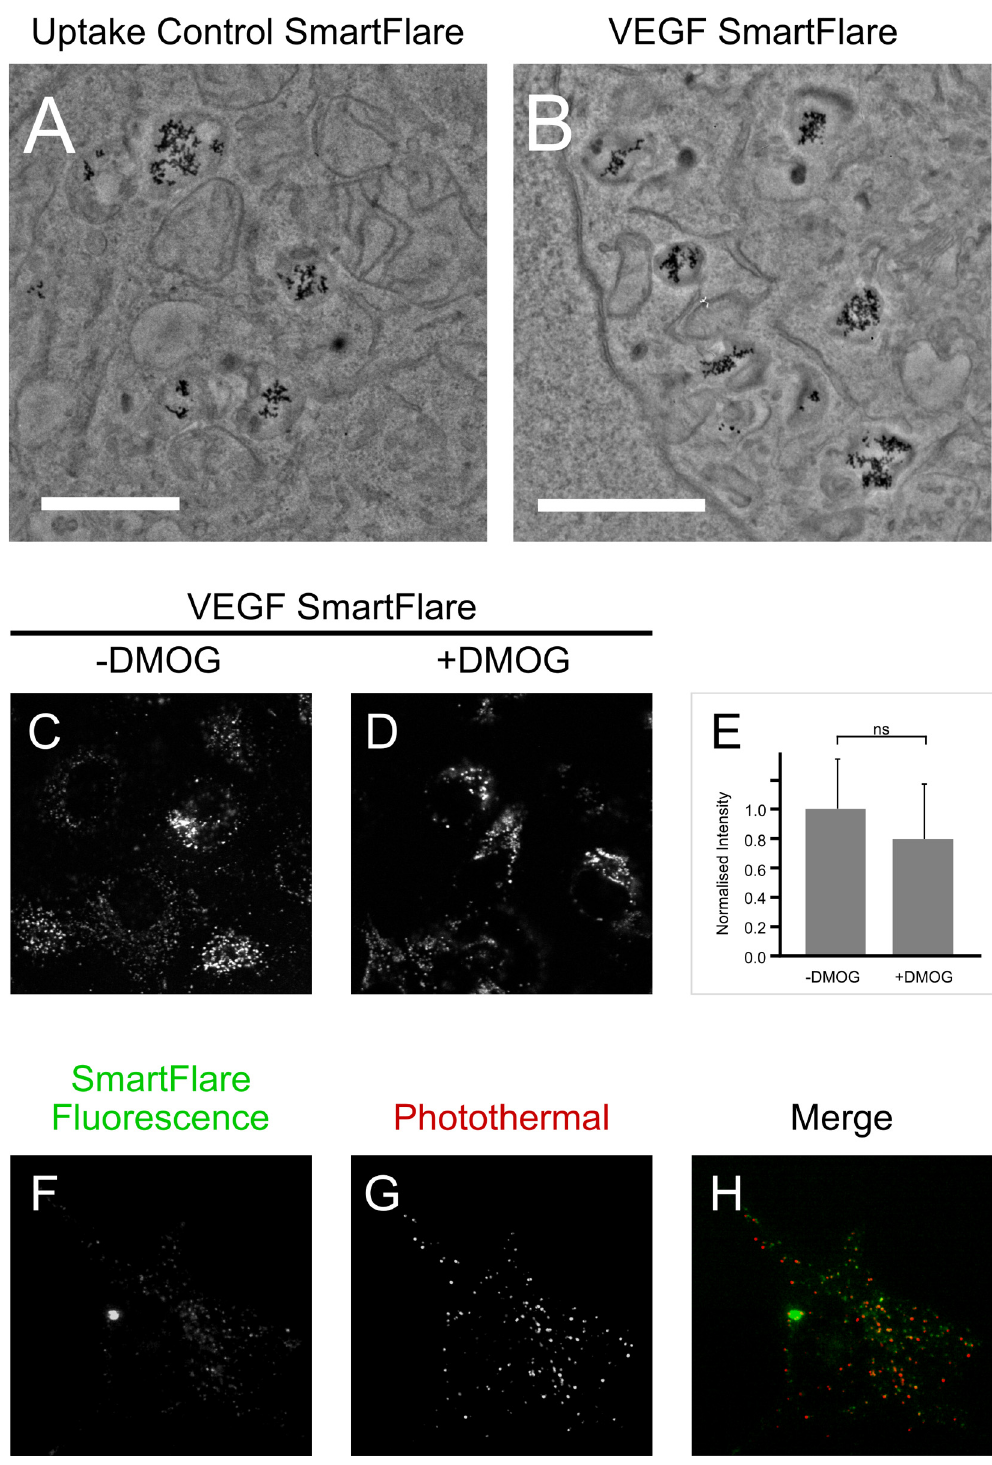
Figure 3. Con fi rming Vesicular Containment of SmartFlares: HeLa cells were loaded with Uptake Control (A) or VEGF (B) SmartFlares for 18 hours then prepared for TEM as detailed in methods. Scale bars represent 1000 nm. Confocal microscopy was used to study VEGF SmartFlare-loaded cells (C) and cells treated with 500 nM DMOG for 18 hours (D). No increase in intensity was observed in three independent experiments (E). Correlative fl uorescence (F) and photothermal (G) microscopy was used to view SmartFlare fl uorescence and gold nanoparticle cores in the same